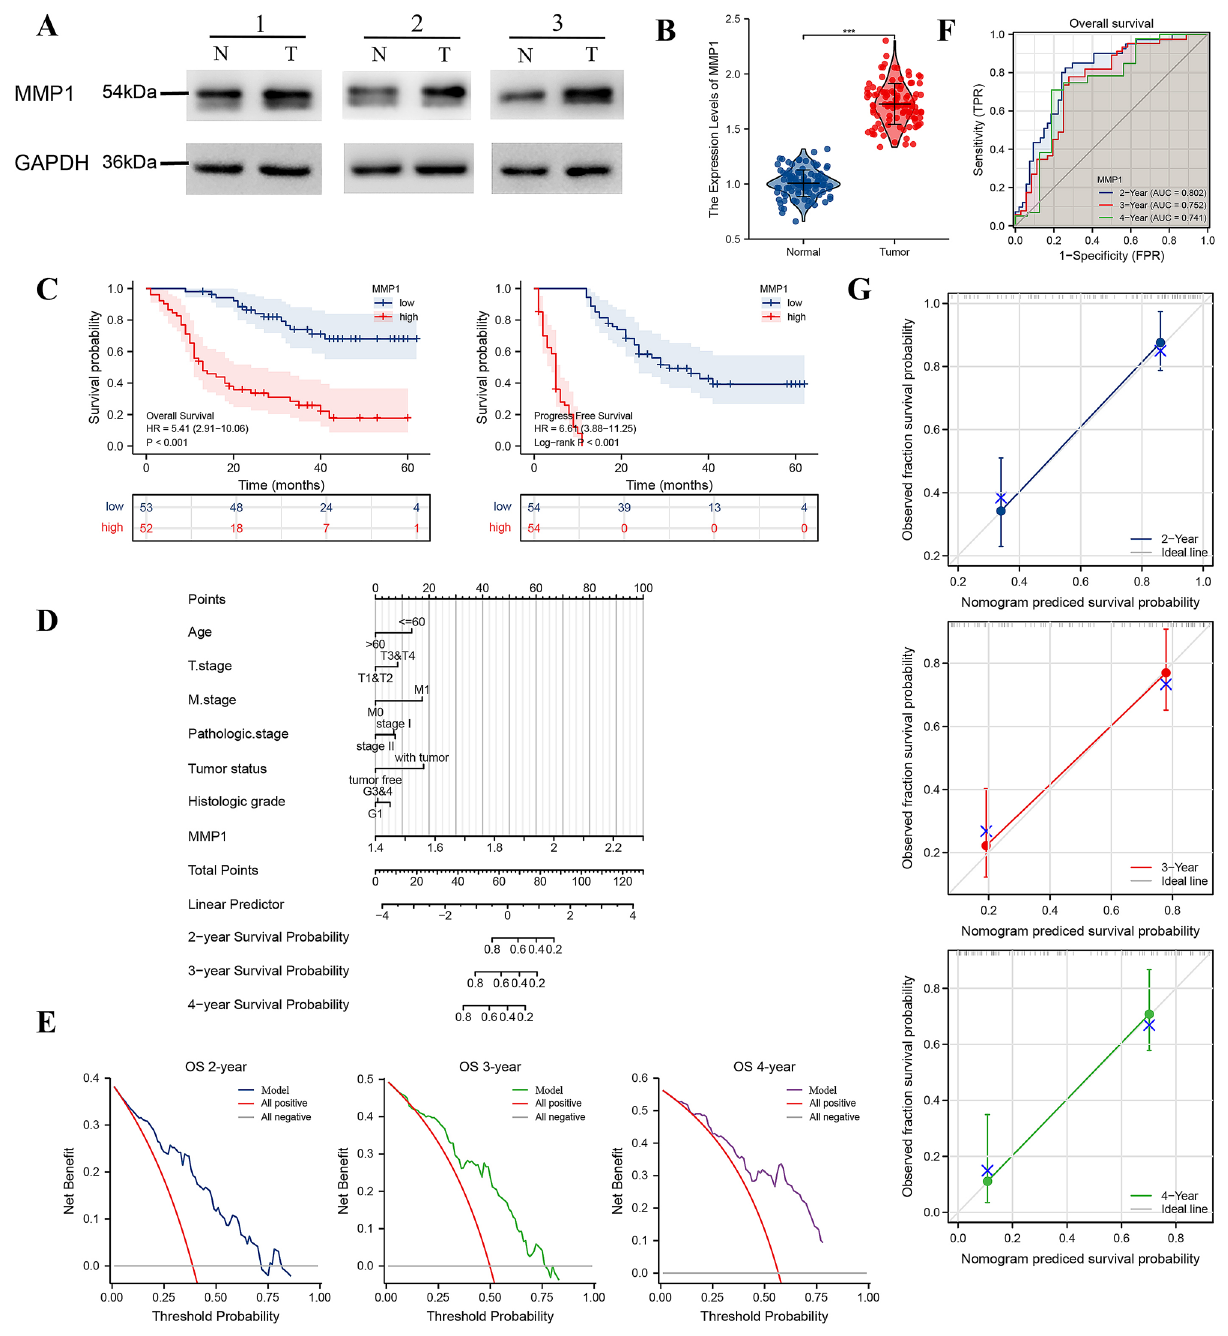
Figure 8. Clinical verification of the MMP1 expression based prognostic model in HCC patients. ( A ) Western blot analysis of MMP1 expression proteins in paired samples from HCC patients (The original images uncropped and the clipping process were shown in supplementary materials); ( B ) qPCR analysis of MMP1 expression in HCC patients; ( C ) Prognosis analysis of MMP1 expression in HCC patients; ( D ) MMP1 expression-based risk prediction nomogram for HCC patients; ( E ) Decision curve analysis of the prognostic model; ( F ) Time dependent ROC curve for accessing the utility of the nomogram; (G) Nomogram calibration curve. HCC, hepatocellular carcinoma. * P < 0.05, ** P < 0.01, *** P <